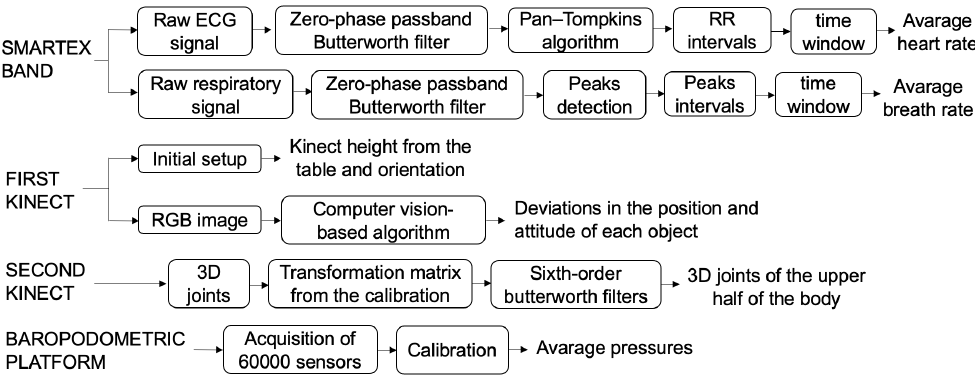
Figure 3. Data processing flow chart.